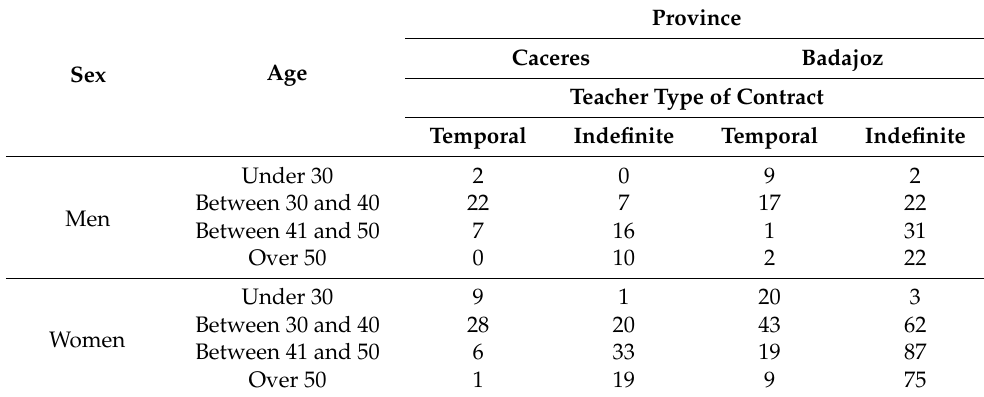
Table 1. Sociodemographic characteristics of the sample ( n =